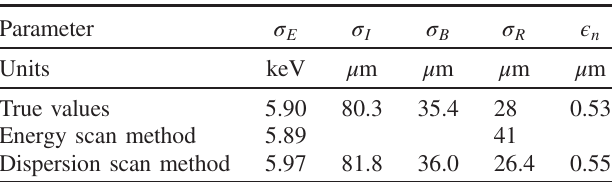
TABLE II. The true and the reconstructed data from the beam dynamics simulations at the reference energy E 0 ¼ 130 MeV.